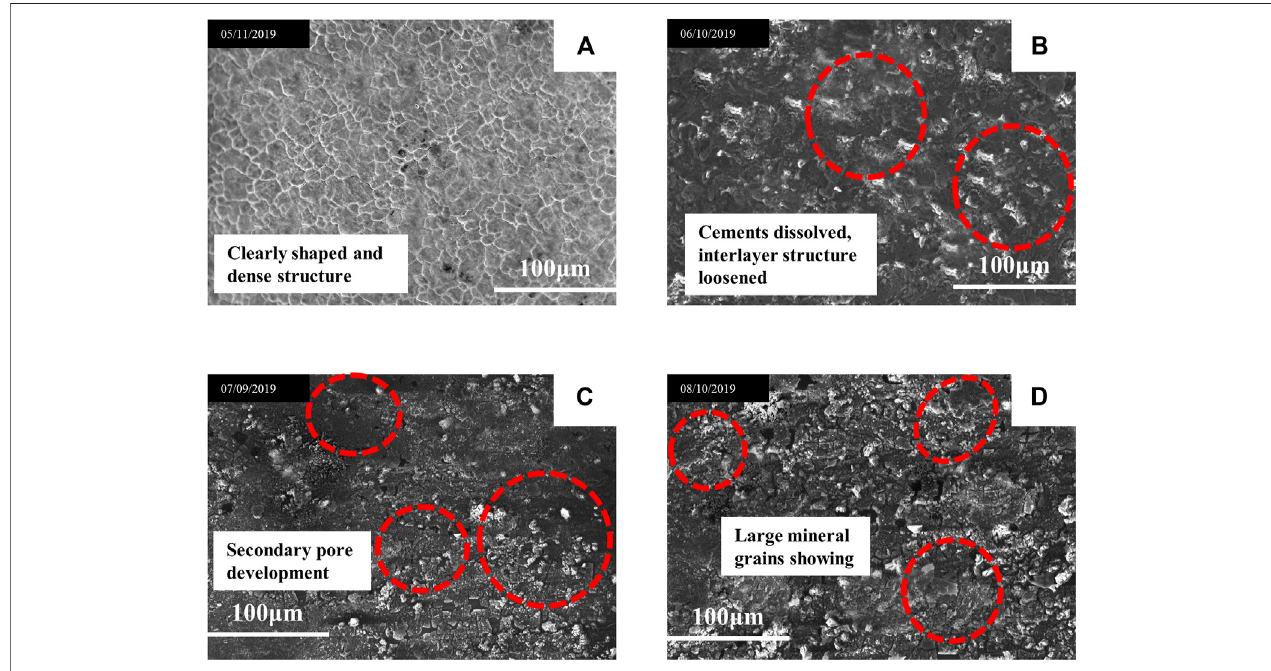
FIGURE 12 | Scanning electron microscope images of dolomite under different high-humidity action times: (A) 0 d; (B) 30 d; (C) 60 d; (D) 90 d.